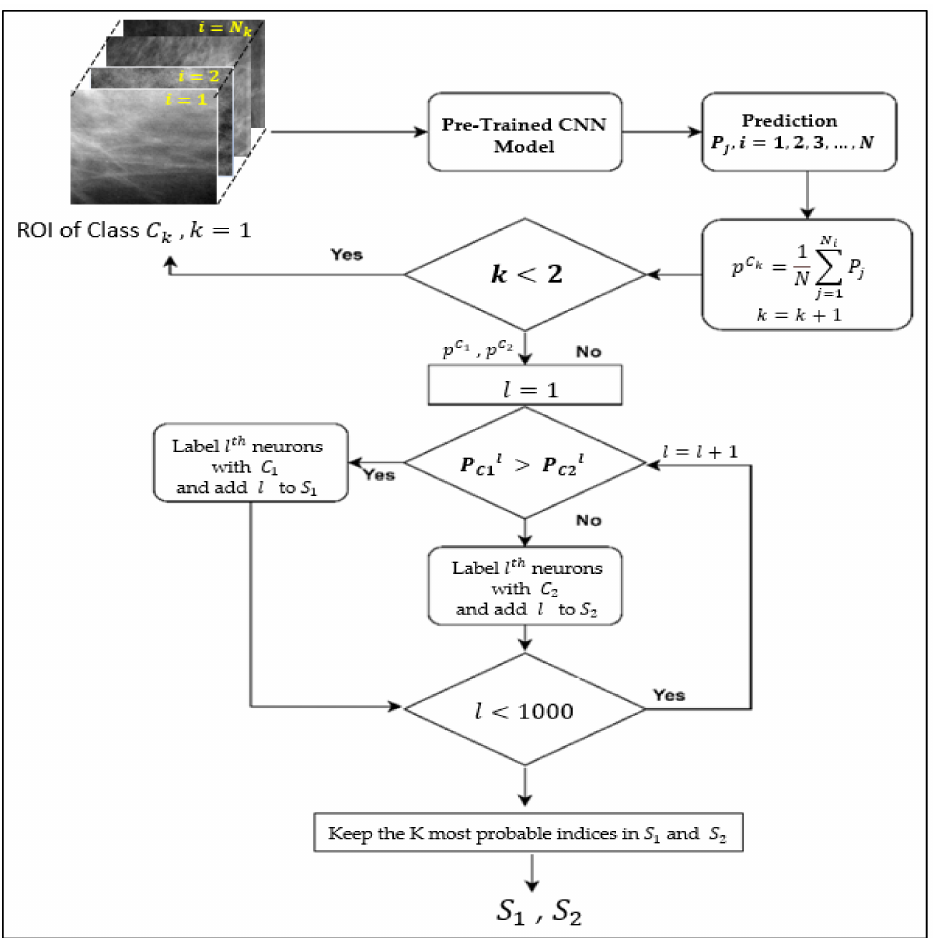
Figure 1. The flow chart of the training